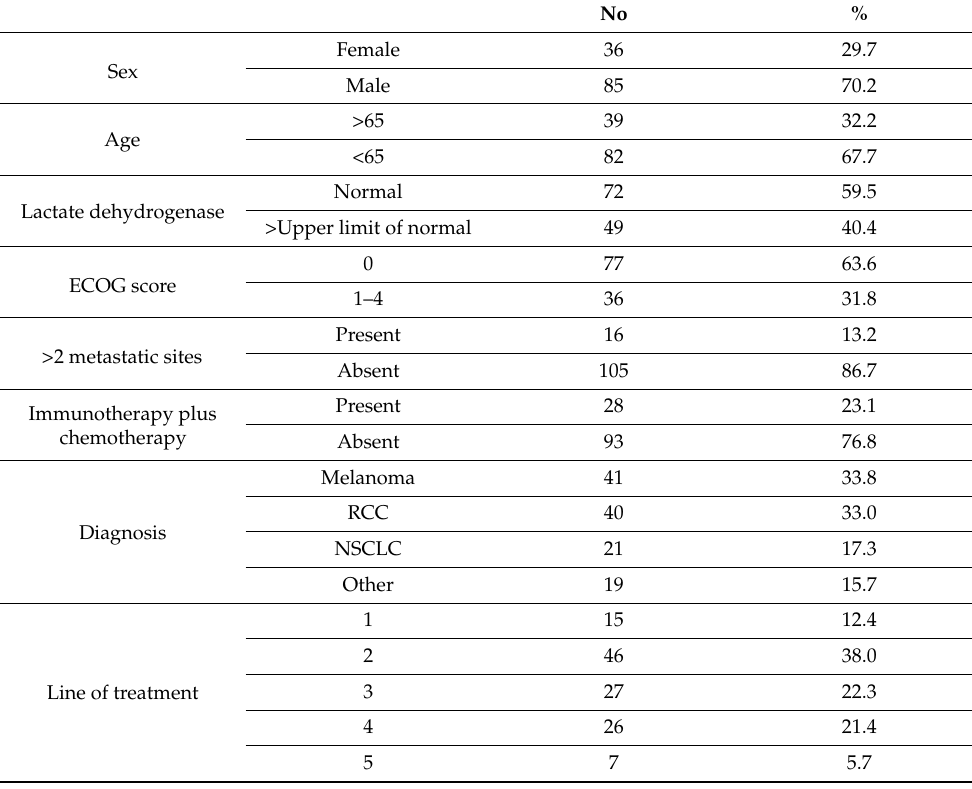
Table 1. Baseline clinical and laboratory features of patients.